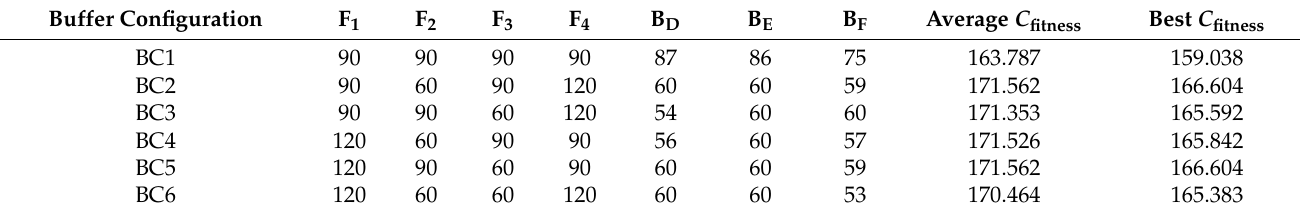
Table 7. Buffer configurations and